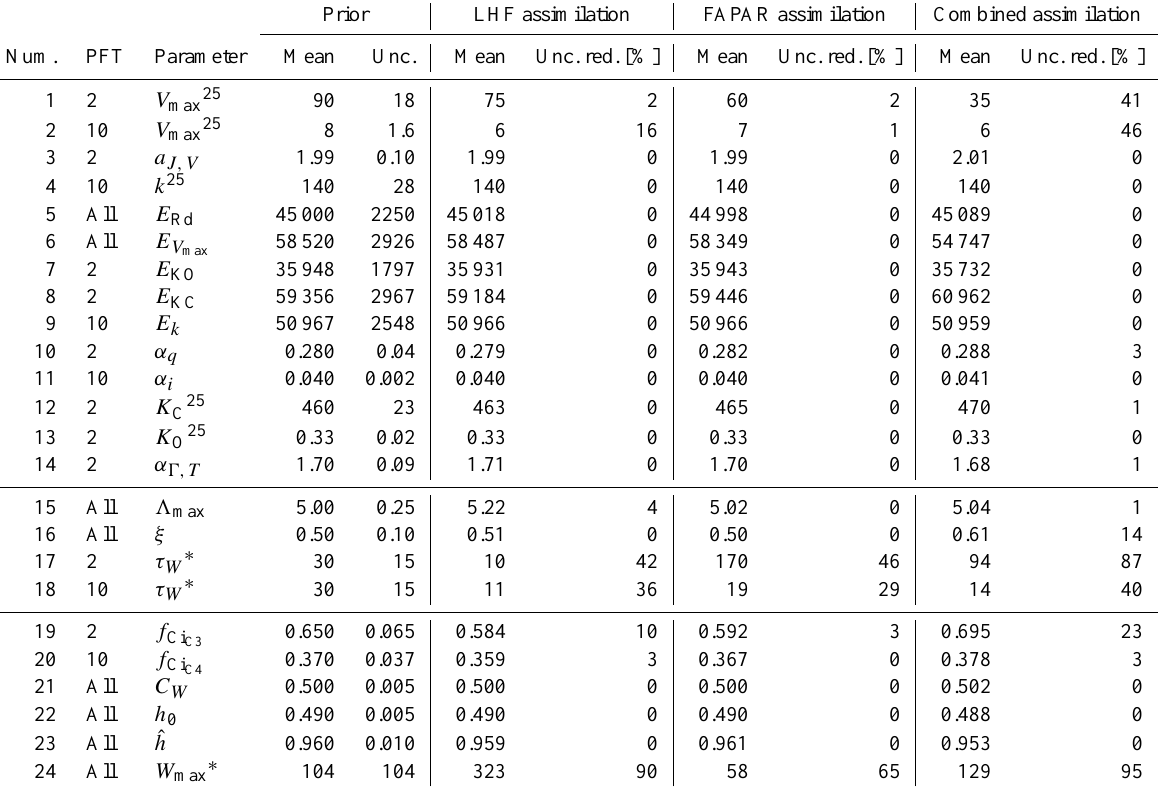
Table 1. List of parameters in prior run and posterior runs assimilating LHF, FAPAR, and the combination of LHF and FAPAR. Uncer- tainty reduction (Unc. red.) is calculated as posterior minus prior uncertainty divided by prior uncertainty. Top rows: physiology; mid- dle: phenology; bottom: energy and water budgets. Units of parameters are V max in µmol(CO 2 )m − 2 s − 1 ; k in µmol(air)m − 2 s − 1 ; α 0,T in